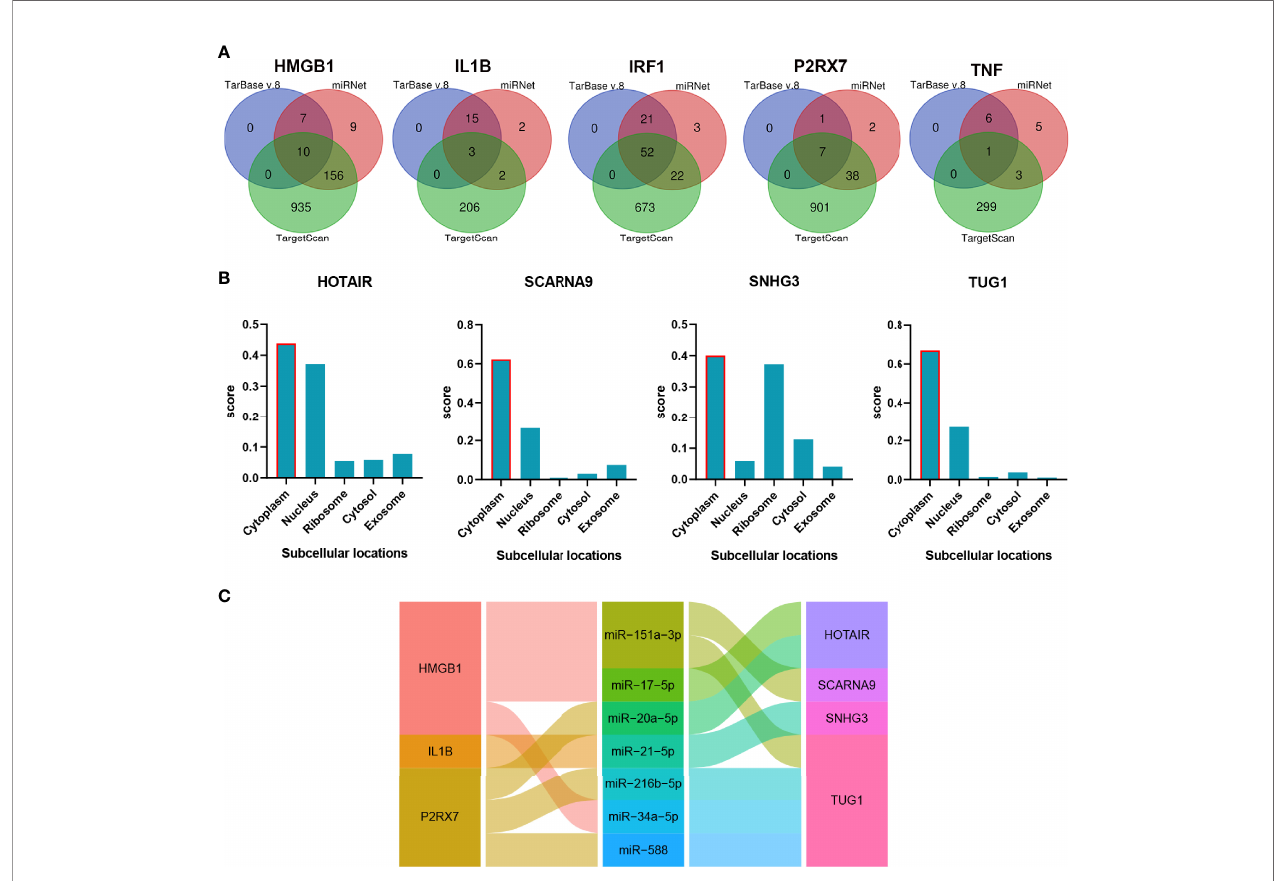
FIGURE 7 | The construction of the lncRNA – miRNA – mRNA ceRNA network of CSU. (A) Venn diagram of miRNAs targeting each hub gene. (B) The subcellular localization of lncRNA of ceRNA. (C) The alluvial diagram of the ceRNA